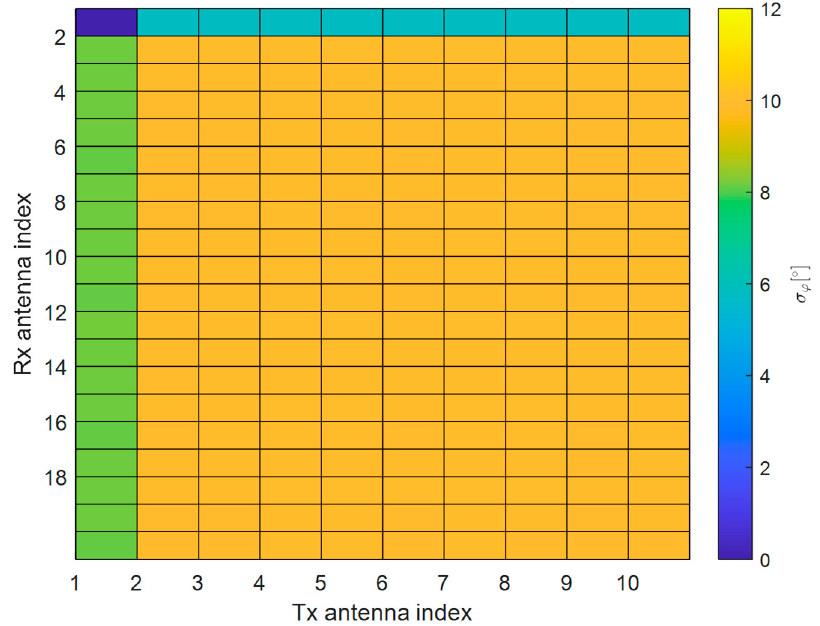
Figure 9. The standard deviation of phase for coefficients of estimated channel matrix Δ𝑨(cid:3553) .